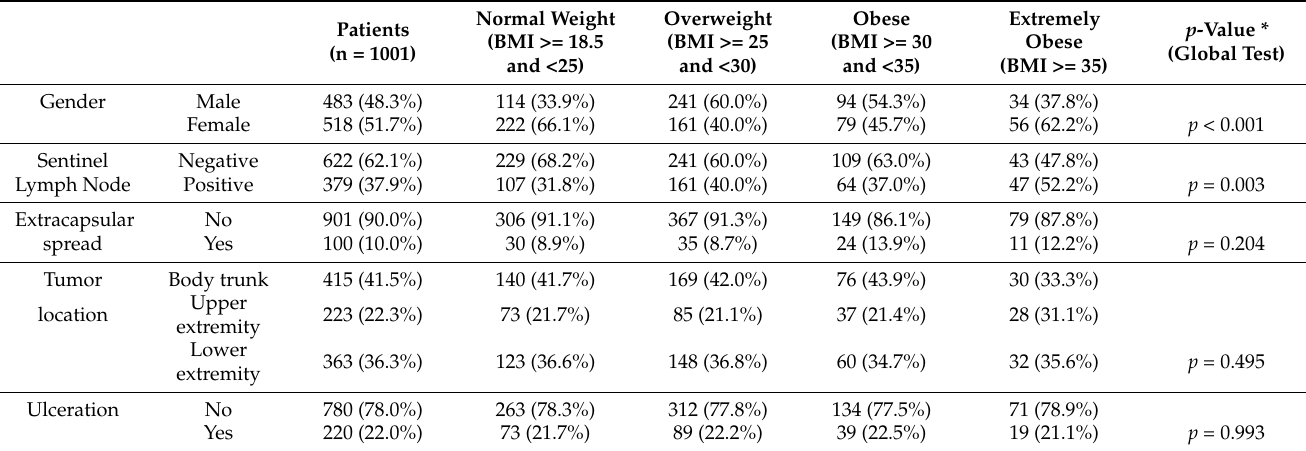
Table 2. Description and comparison of BMI groups—categorical